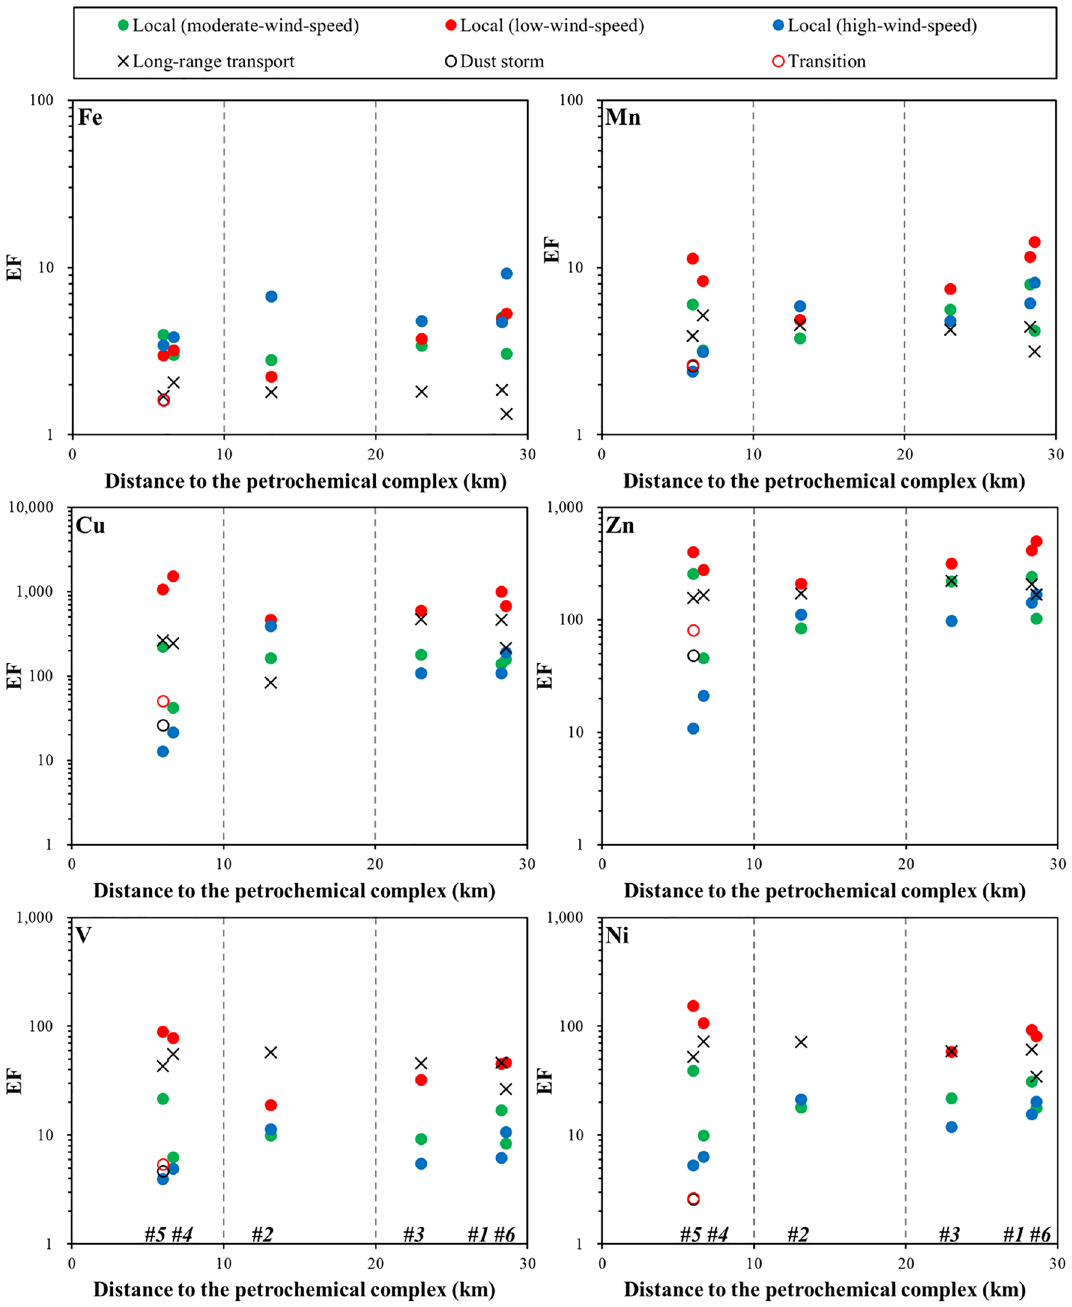
Figure 2. Enrichment factors (EFs) of elements (Fe, Mn, Cu, Zn, V, Ni, Mo, Cd, As, Pb, Sb, and Ti) versus distance to the petrochemical complex for all events collected in this